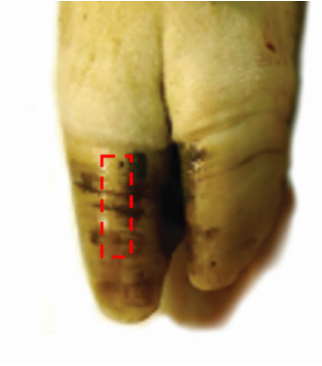
Figure 1. Location of the hoof horn